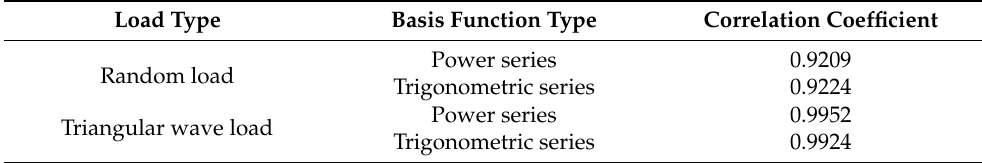
Table 3. Correlation coefficients of load identification and real values (noise level: 5%).